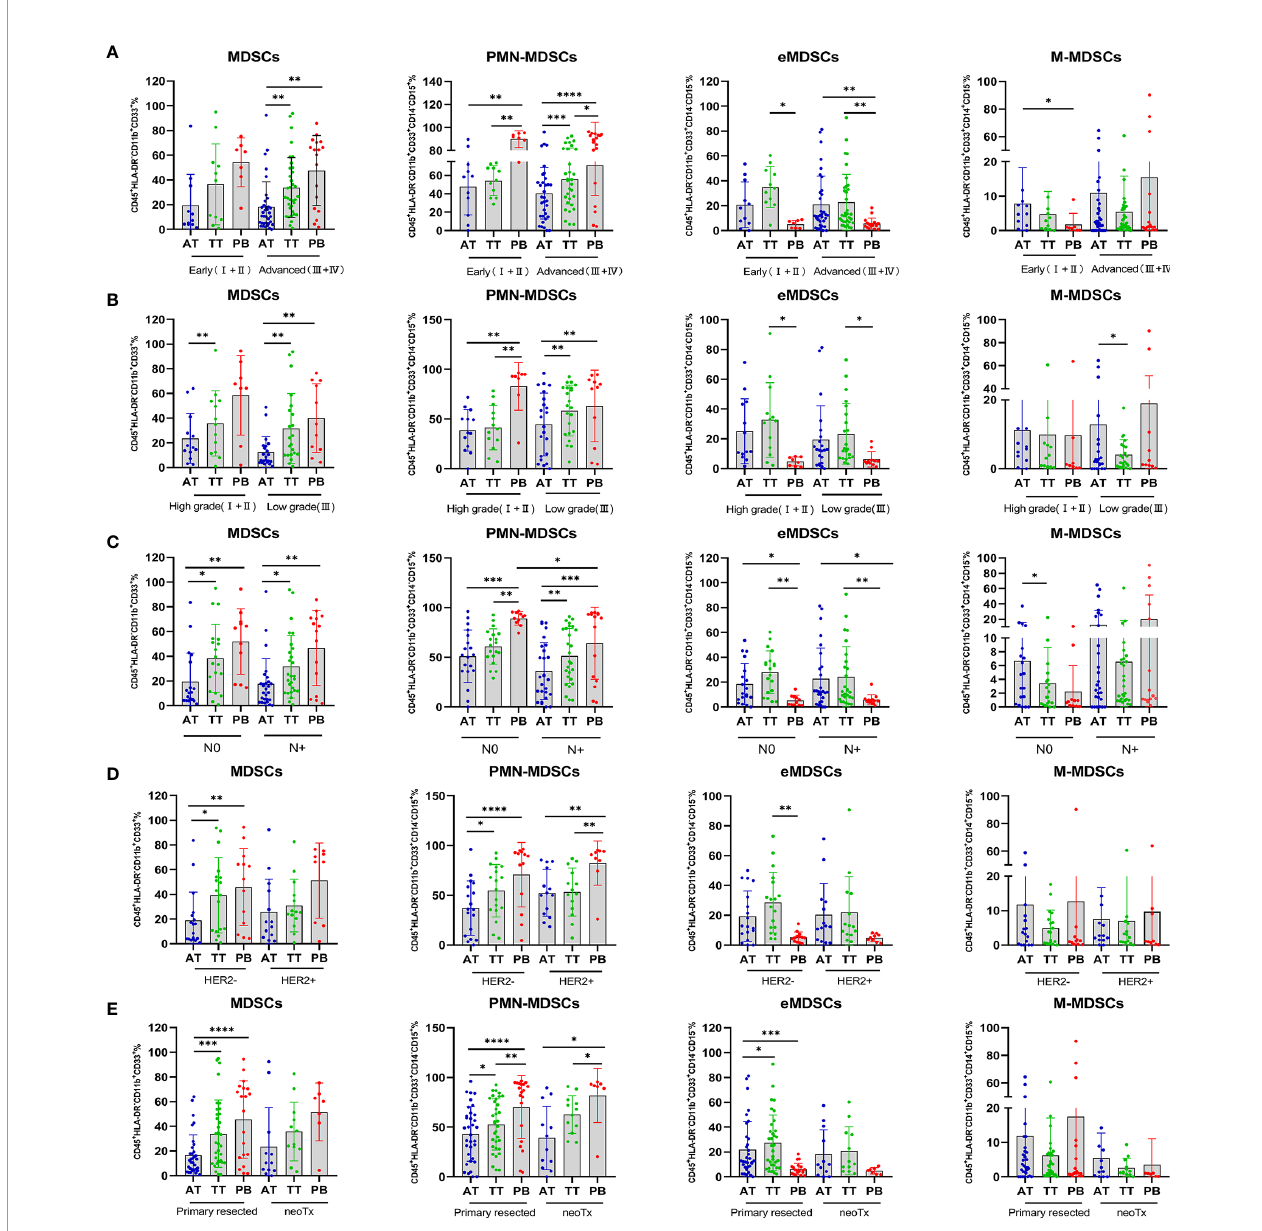
FIGURE 4 | Percentage of MDSCs and three subsets of MDSCs in AEG patients with different clinicopathological characteristics. Analysis of MDSCs, PMN-MDSCs, eMDSCs, and M-MDSCs, cells frequencies in adjacent tissues (AT), tumor tissues (TT), and peripheral blood (PB) of AEG patients at different staging (early ;+ vs. advanced +) (A) , histopathologic grading (low vs. high) (B) , lymph node metastasis (N0 vs. N+) (C) , HER2 expression (HER2 − vs. HER2+) (D), and therapy (primary resected vs. neoTx) (E) were examined by multicolor fl ow cytometry. The frequencies of MDSCs, PMN-MDSCs, eMDSCs, and M-MDSCs in the AT (n = 46), TT (n = 46), and PB (n = 27) are presented as the percentage of the total respective subset. The percentages of MDSCs subsets from the three tumor microenvironments were determined in the same patients as described in Figure 2. Each point corresponds to an individual AEG patient. Data depict the mean ± SEM. The p values are represented as follows: (*p < 0.05; **p < 0.01; ***p < 0.001; ****p <